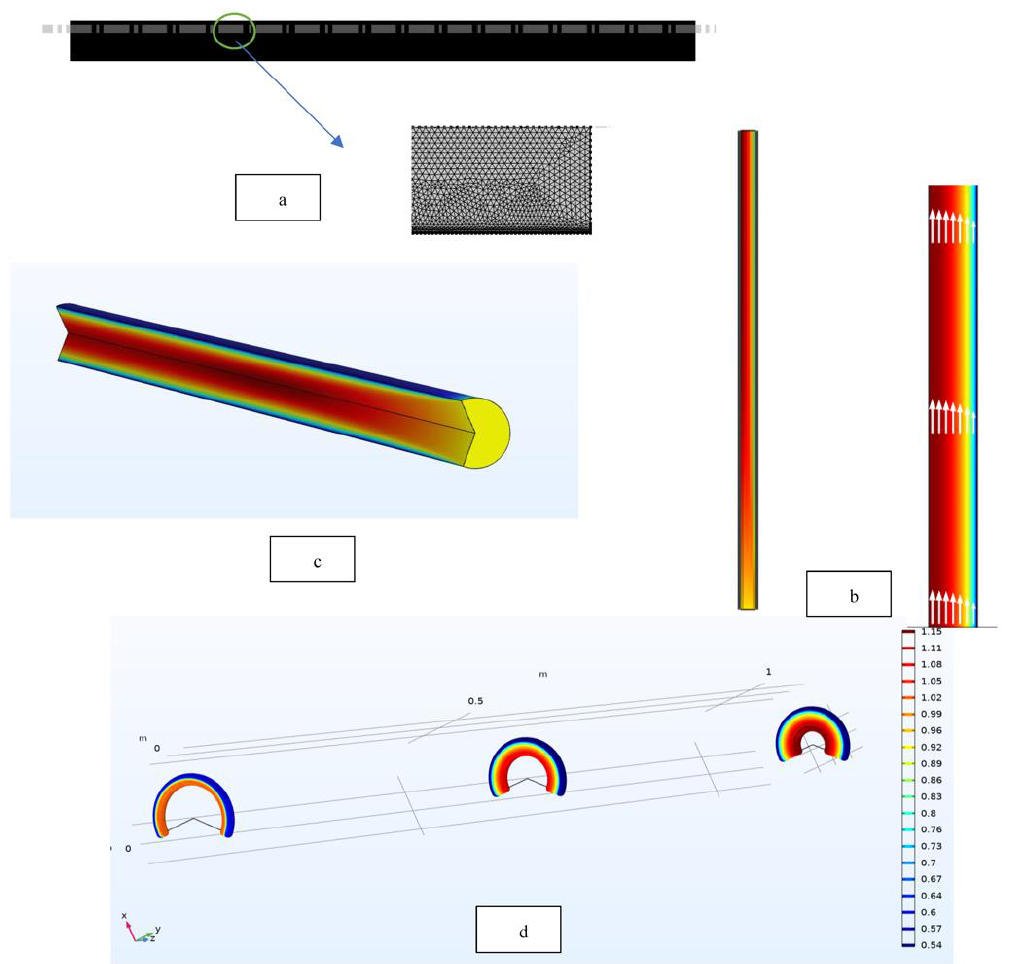
Figure 3. Dynamic simulation pattern ( a ) Geometry of the pipeline, ( b ) Pipeline meshing, ( c ) Velocity disruption, ( d ) Velocity development along the 1-m-long pipeline.